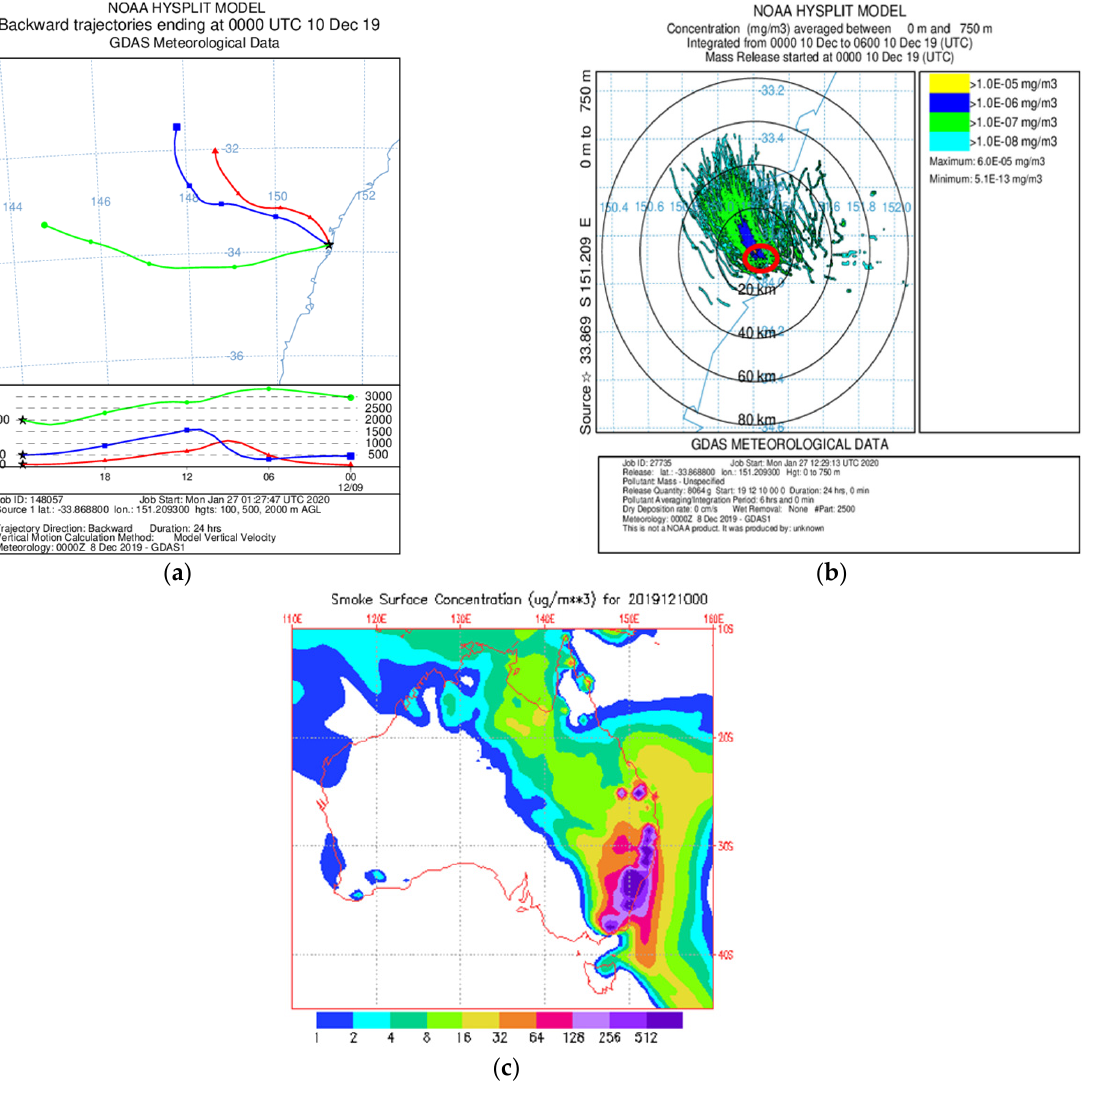
Figure 10. ( a ) The 24 h backward trajectories from the HYSPLIT model were calculated over Sydney at 100 m, 500 m and 2000 m above ground level for 10 December 2019 at 00:00 UTC. ( b ) The HYSPLIT dispersion model was used to determine the 24 h smoke plume dispersion from the bushfires in the Blue Mountains around Sydney for 10 December 2019 at 00:00 UTC. The centre of the red circle is the city of Sydney. ( c ) Surface smoke concentrations ( µ g/m 3 ) obtained from the NAAPS Aerosol Model for 10 December